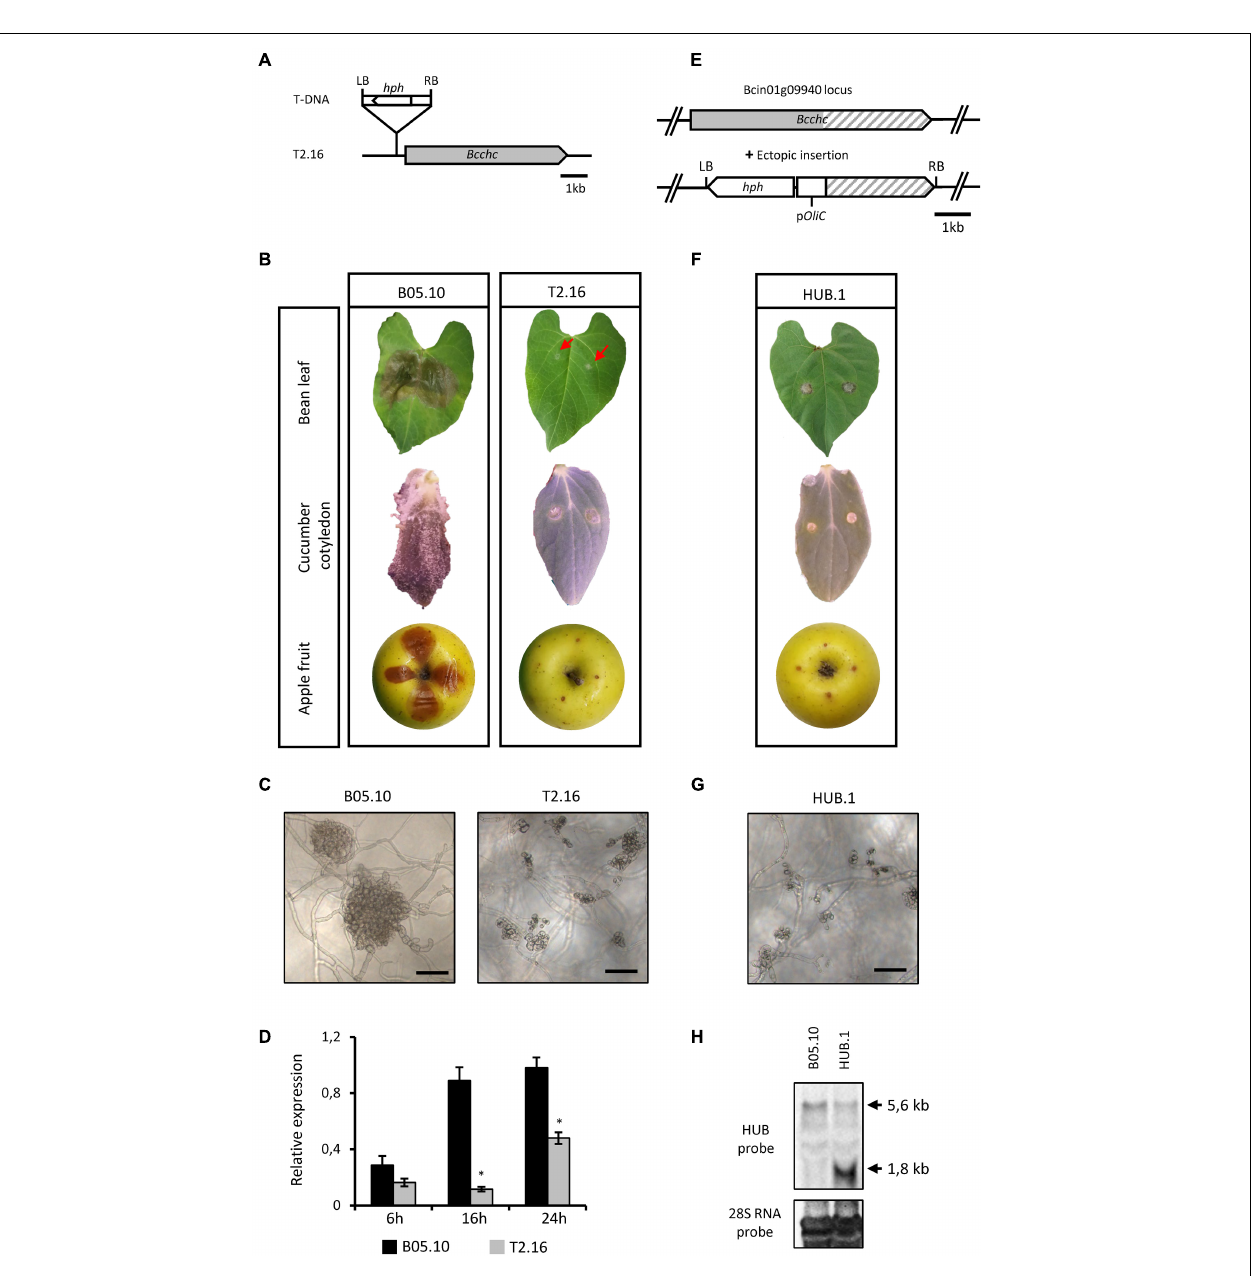
Frontiers in Plant Science |